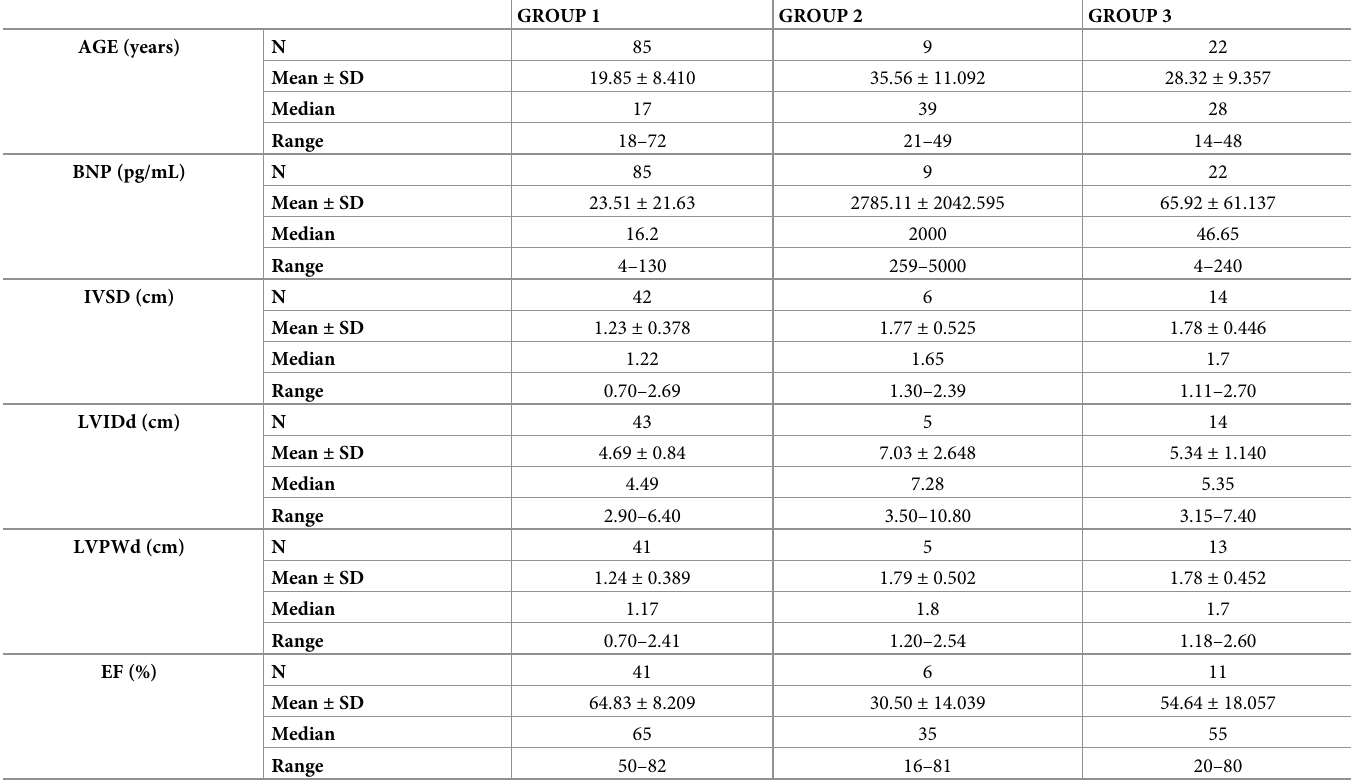
Table 1. Age, BNP level, diastolic interventricular septal wall thickness (IVSd), left ventricular internal diameter in diastole (LVIDd), left ventricular diastolic pos- terior wall thickness (LVPWd), and ejection fraction (EF) measurements for Groups 1, 2 and